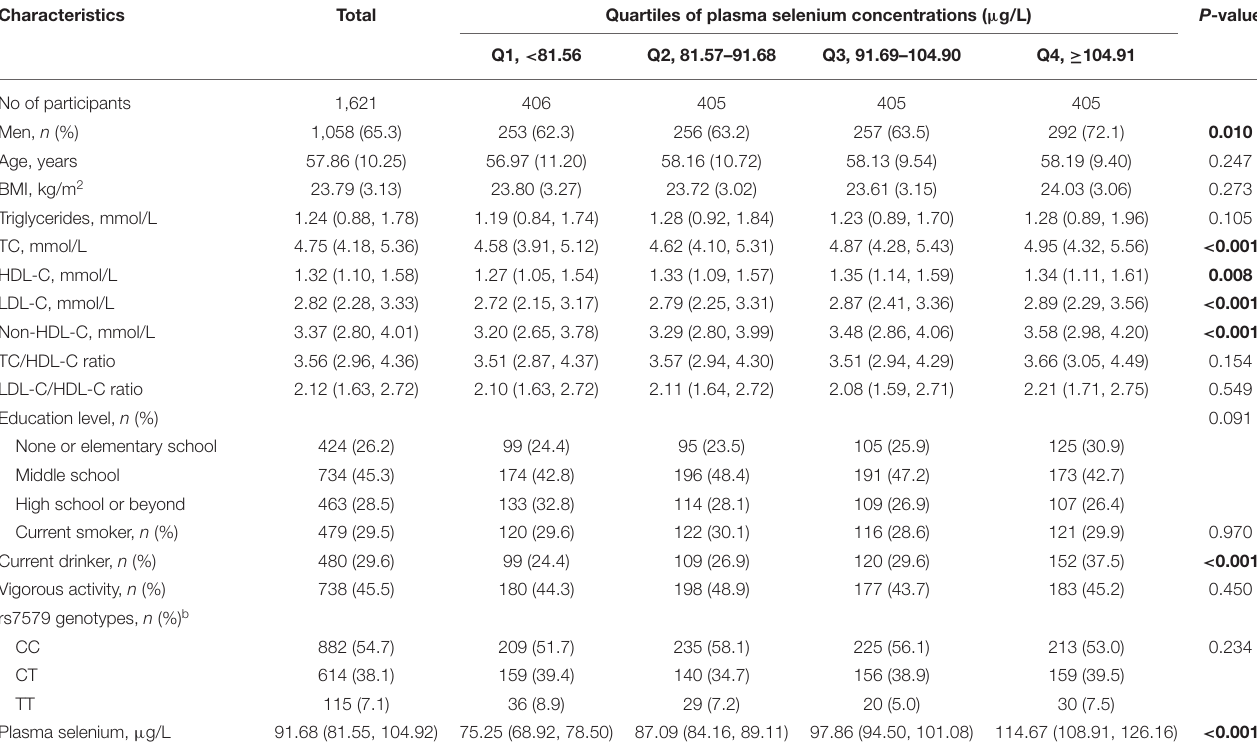
TABLE 1 | Baseline characteristics of participants a .